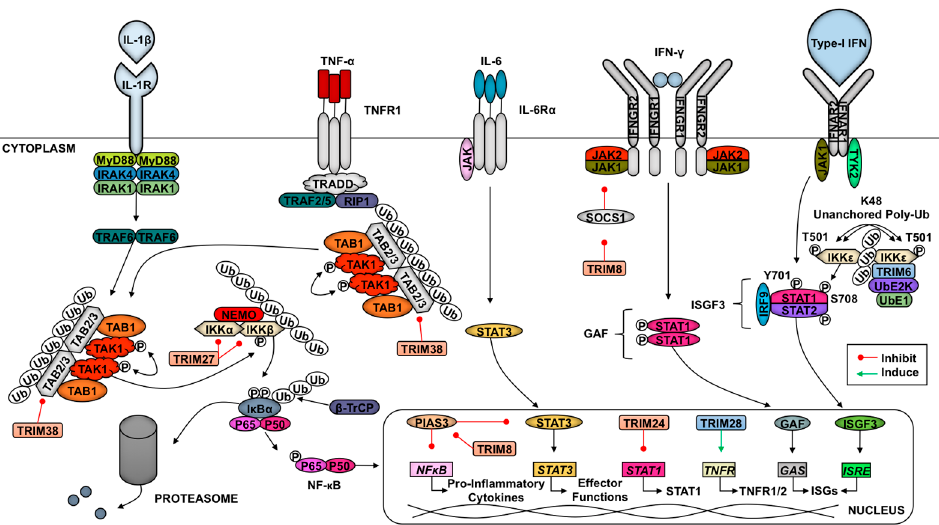
Figure 2. TRIMs in cytokine signaling. Downstream of the initial pathogen recognition and induction of pro-inflammatory cytokines, TRIMs can regulate their cytokine signaling pathways through interactions with cytokine receptor adaptors (TAB2/3) and enzymatic proteins (IKK α , IKK β and IKK ε ) within the signaling complexes, the activity and stability of pathway negative regulators (Protein Inhibitor of Activated STAT 3 (PIAS3), suppressor of cytokine signaling (SOCS), and influence the transcription of various cytokine-effector genes (NF- κ B-induced pro-inflammatory cytokines, signal transducer and activator of transcription (STAT)-induced genes, interferon stimulated genes (ISGs)) or cytokine signaling regulators (tumor necrosis factor (TNF) receptors (TNFR1/2, and STAT-induced genes)).